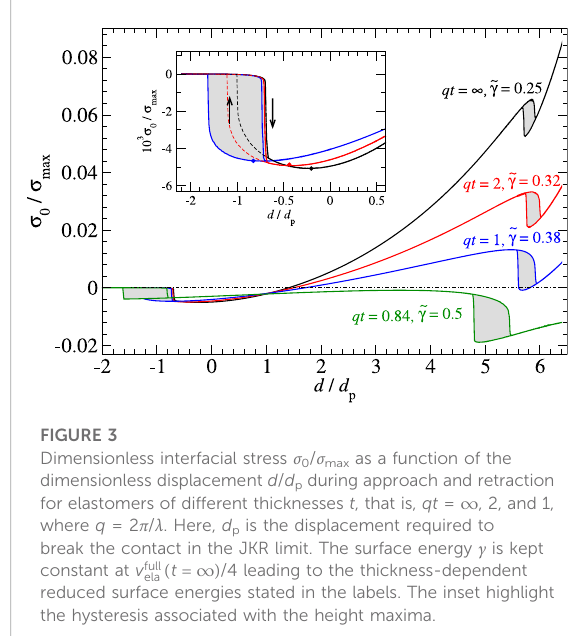
FIGURE 2 Displacement of selected modes, ~ u ( q , τ ) , as a function of time step τ during the fi rst instability on approach for qt = 2, γ ′ = 0.41 leading to ~ γ (cid:1) 0 . 32. u 0 is the constrained center-of-mass mode, which is ramped to its new value over 50 time steps and then kept constant for another 400 time steps. Two additional modes are shown, that is, one with a small wave vector, q = 2 π / L , and the other with a large wave vector, q = 2 π / Δ a . Displacements are rescaled for better visualization.